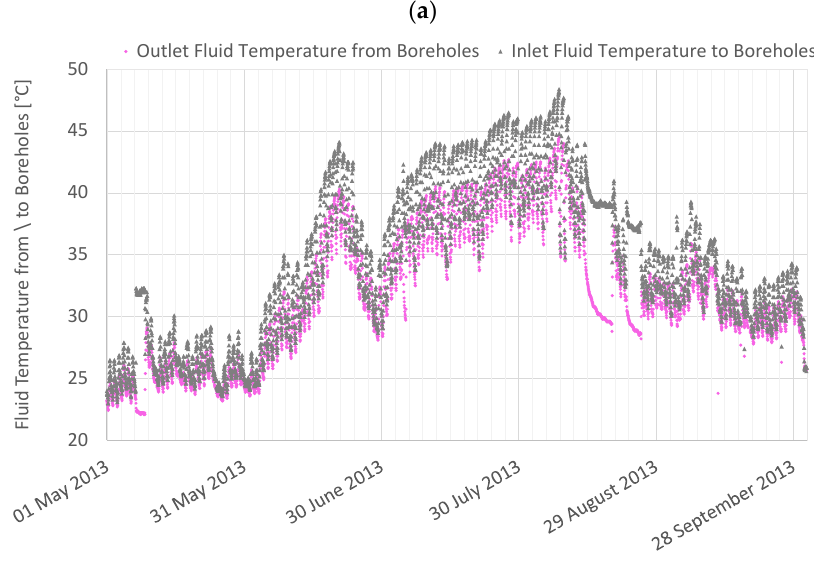
Figure 4. Scheme of the new hybrid heat pump: ( a ) operation in cooling mode using borehole heat exchangers; ( b ) operation in cooling mode using air ‐ condenser; ( c ) operation in heating mode using borehole heat exchangers. The borehole heads are buried at about 1 m beneath the ground surface. Double U ‐ tube heat exchangers are installed inside the boreholes and the outside (inside) diameter of the pipe is 32 mm (26 mm); the borehole diameter is 140 mm. The two U ‐ tubes inside each borehole heat exchanger are coupled in parallel. The heat ‐ carrier fluid inside the ground heat exchangers is pure water with a total constant mass flow rate equal to 5.56 kg/s. On the building side, the total mass flow rate of heat ‐ carrier fluid (i.e., water) is equal to 6.10 kg/s. The fluid mass flow rates in the loops were considered constant over the simulation time; clearly when the GSHP is switched off, CaRM calculates the temperature in each thermal node of the domain according to the transient heat balance, therefore